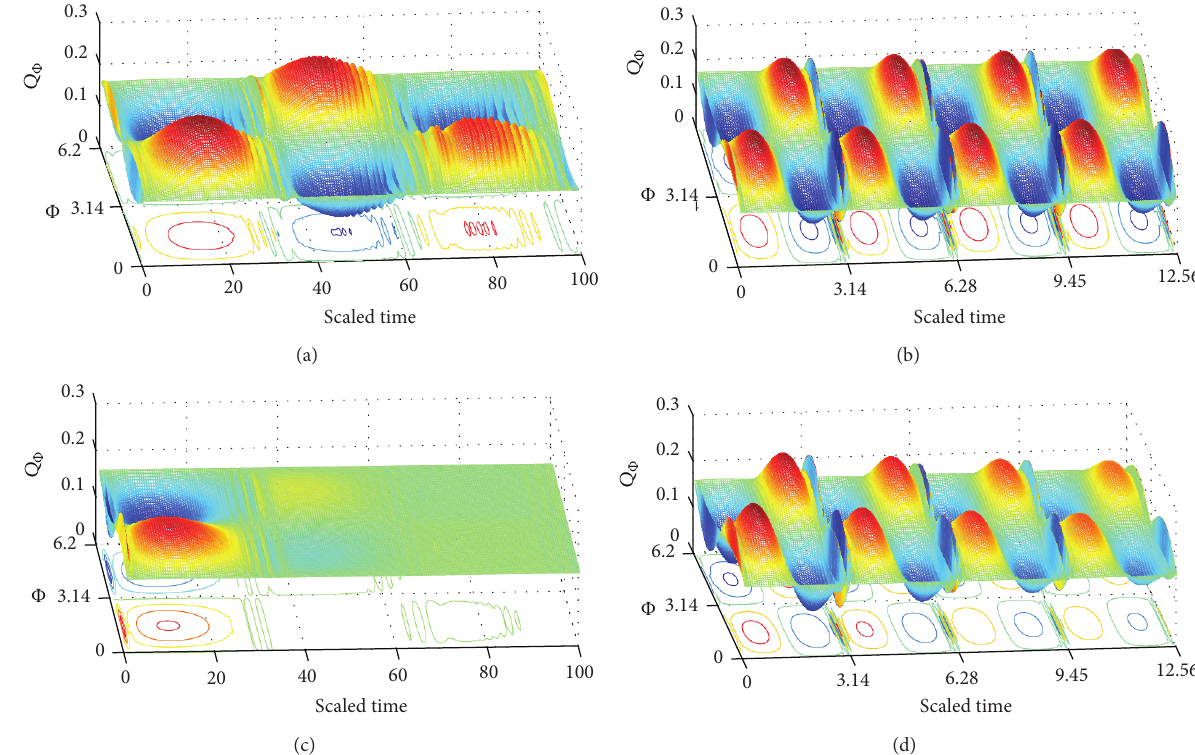
Figure 3: The surface plot of the marginal atomic Q -function 𝑄 Φ (𝑡) versus the dimensionless time 𝜆𝑡 and the atomic phase space parameter Φ for 𝛼 = 5 and with different values of the number of photon transition 𝑘 and atomic damping parameter 𝛾/𝜆 where (a) (𝑘,𝛾/𝜆) = (1,0.0001) , (b) (𝑘, 𝛾/𝜆) = (1, 0.1) , (c) (𝑘,𝛾/𝜆) = (2,0.0001) , and (d) (𝑘,𝛾/𝜆) = (2, 0.1)